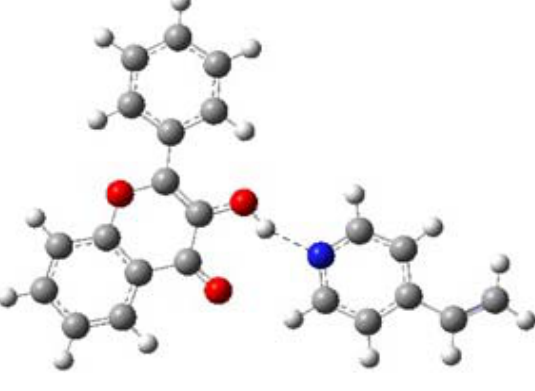
Table 7. Binding energies, ∆ E , of FL with MAA and 4VPy.